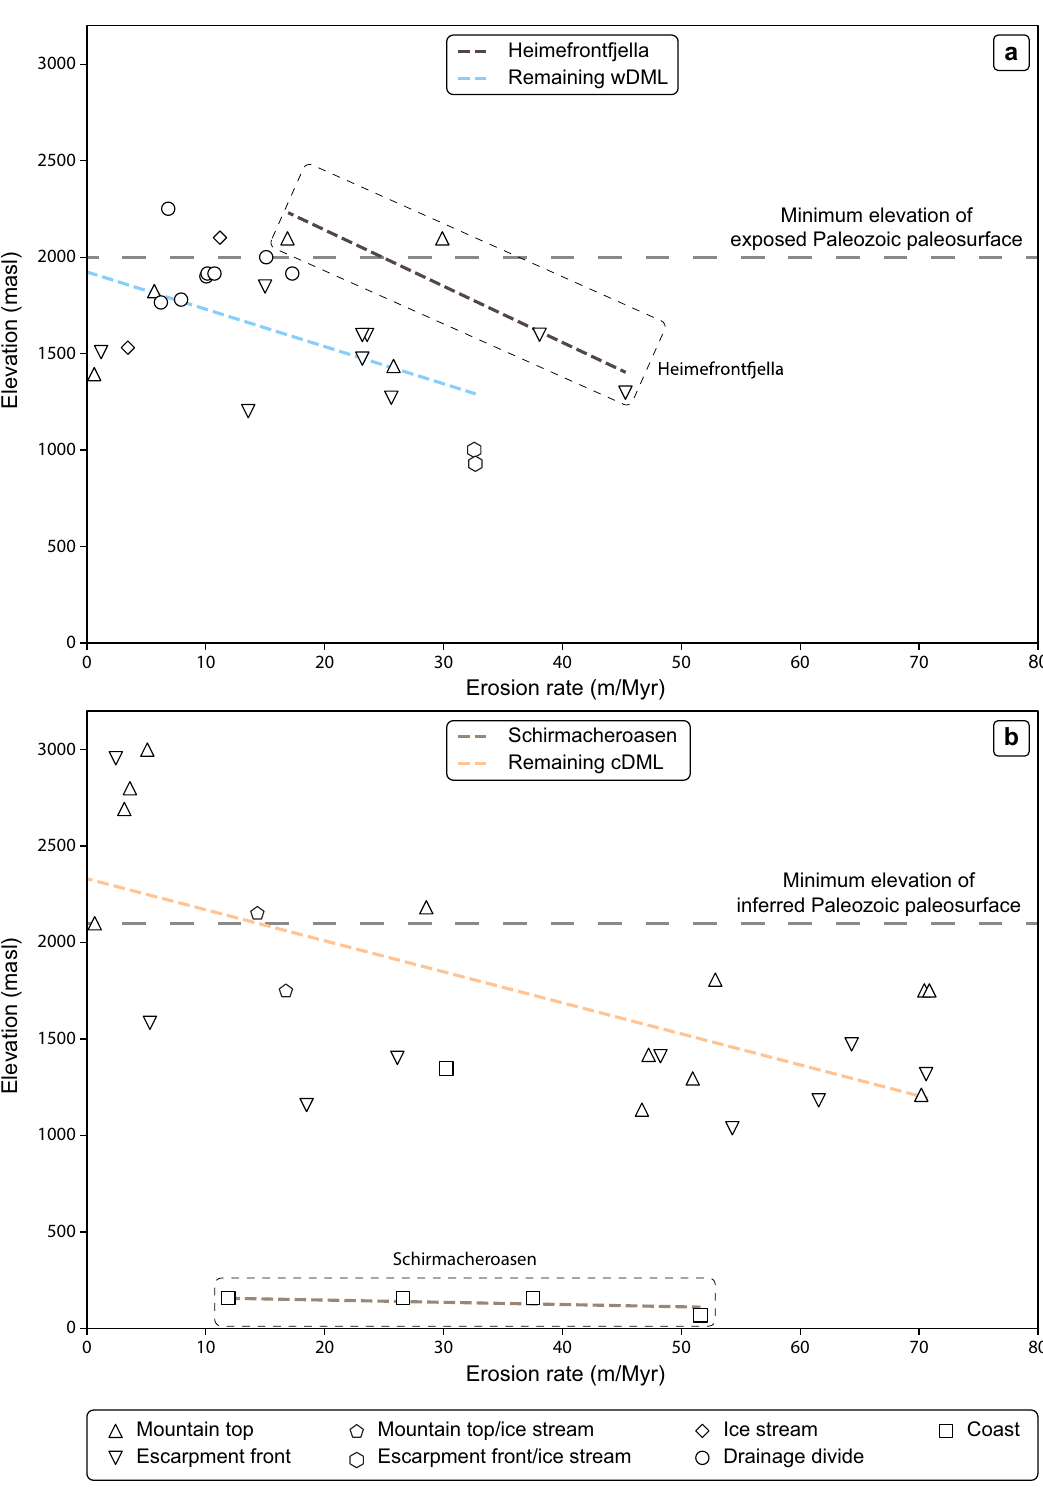
Fig. 3 Calculated time-averaged erosion rate in relation to elevation and geomorphic setting. Samples from three out of four different regions in DML show a similar negative linear correlation between erosion rates and elevation. a In wDML, erosion rates (over 34 Myr) up to c. 45 m/Myr are recorded. Samples from Heimefrontfjella and other areas in wDML follow similar negative trendlines, although the two different regions are offset. The erosion rates are generally higher in Heimefrontfjella, most likely explained by the difference in drainage areas: While Heimefrontfjella is governed by the Endurance glacier catchment into the Weddell Sea, the remaining parts of wDML drain northward into the Lazarev Sea. b Erosion rates in cDML show a similar correlation to elevation as in wDML, however, reaching time-averaged erosion rates up to c. 70 m/Myr (over 34 Myr). The coastal Schirmacheroasen region is somewhat different: All samples come from similar elevations, but samples show highly different erosion rates. Details on the conversion from temperature to erosion rate (i.e., geothermal gradients) are reported in Supplementary Notes